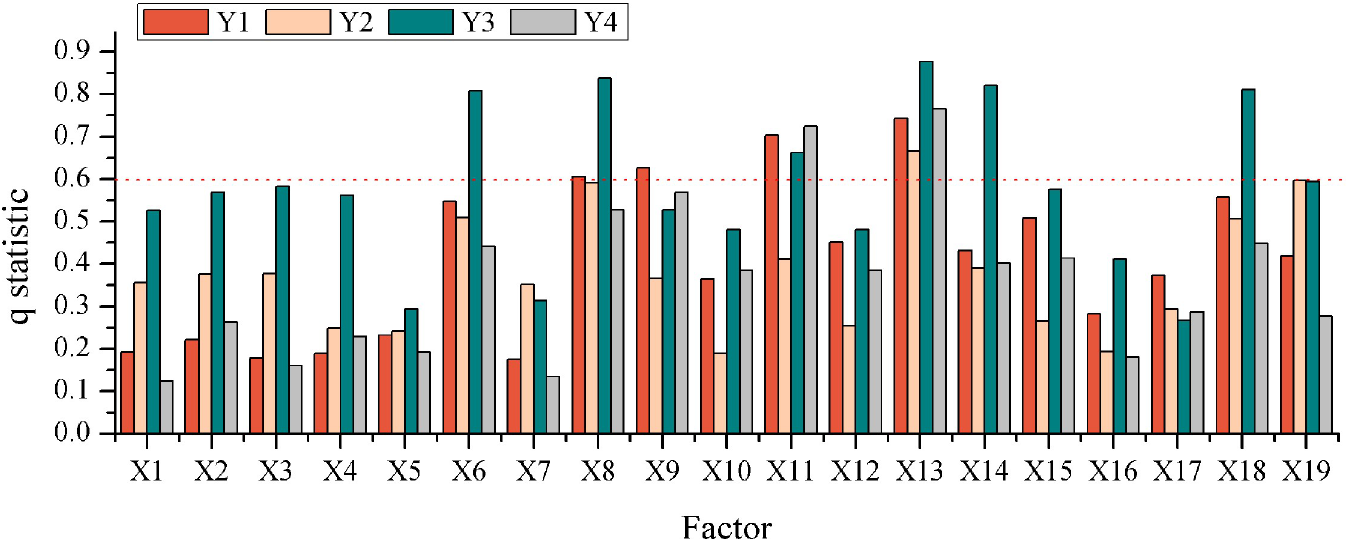
Fig 5. Analysis results of the geographical detector (q). The X-axis represents 19 factors that influence the spatial distribution of Beijing’s hotel industry, and the Y-axis represents the degree of influence of different factors on the spatial distribution of Beijing’s hotel industry. The data is calculated by formula (3), the figure is drawn by Qrigin.